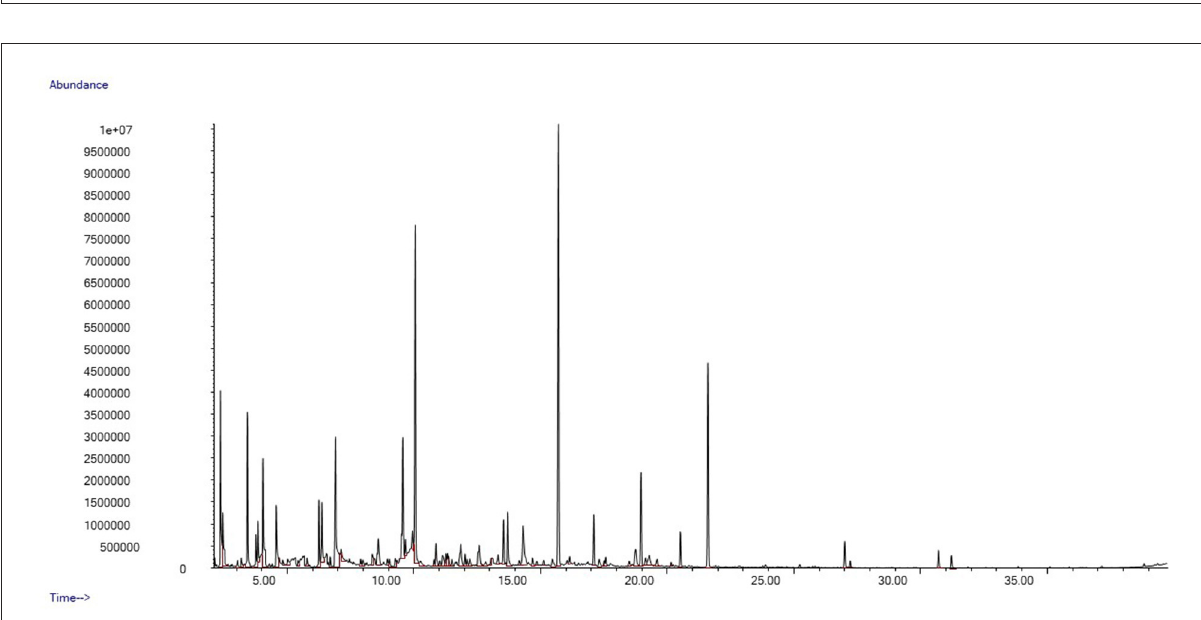
FIGURE4 Example chromatogram from female gentle lemur, anogenital odour sample during the non-fertile